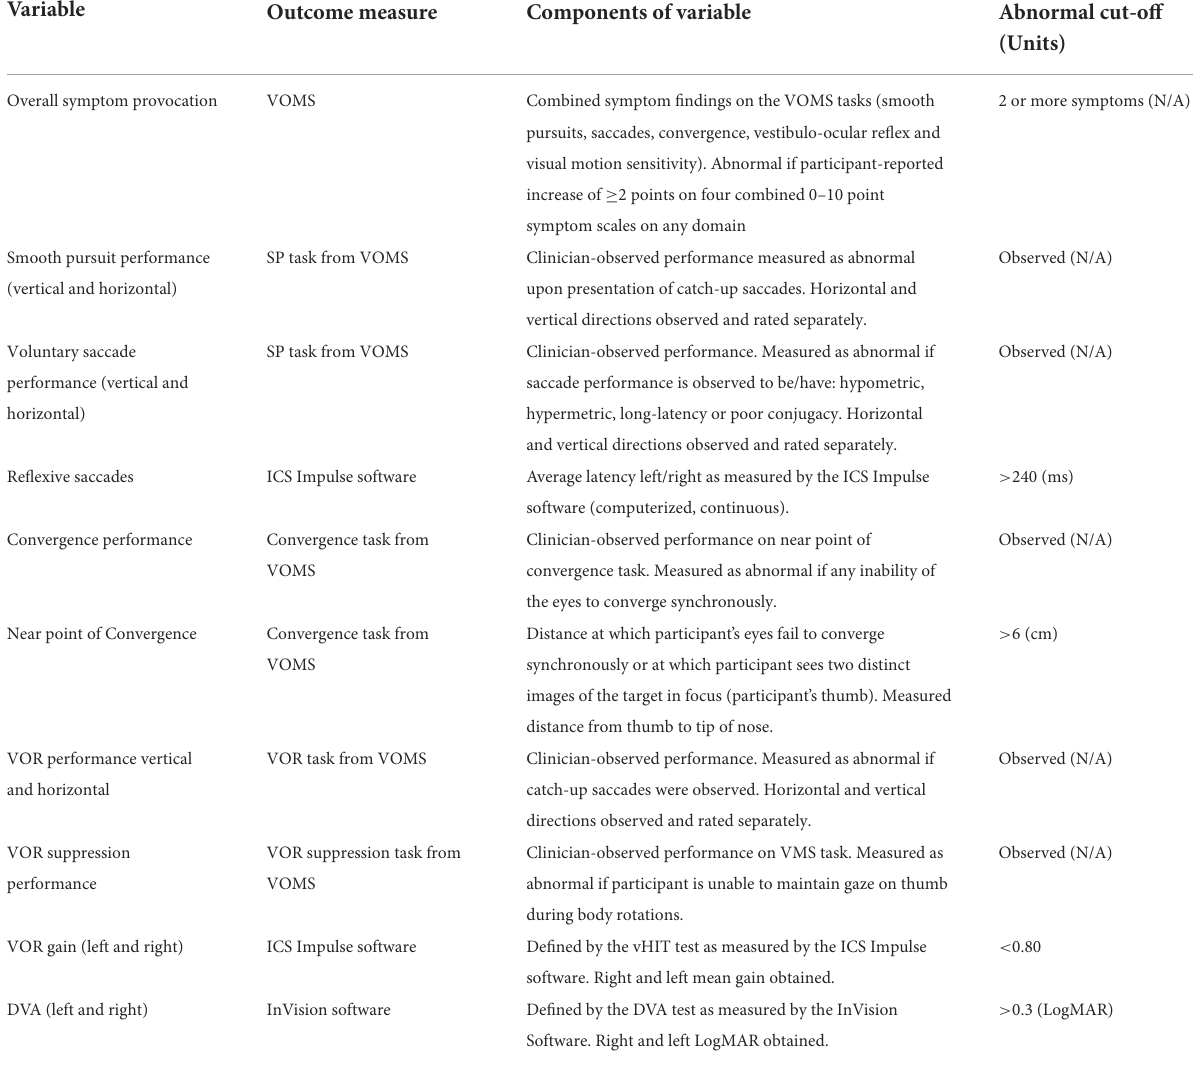
TABLE 1 Variables analyzed to determine changes over time in subcomponents contributing to OM and VOR